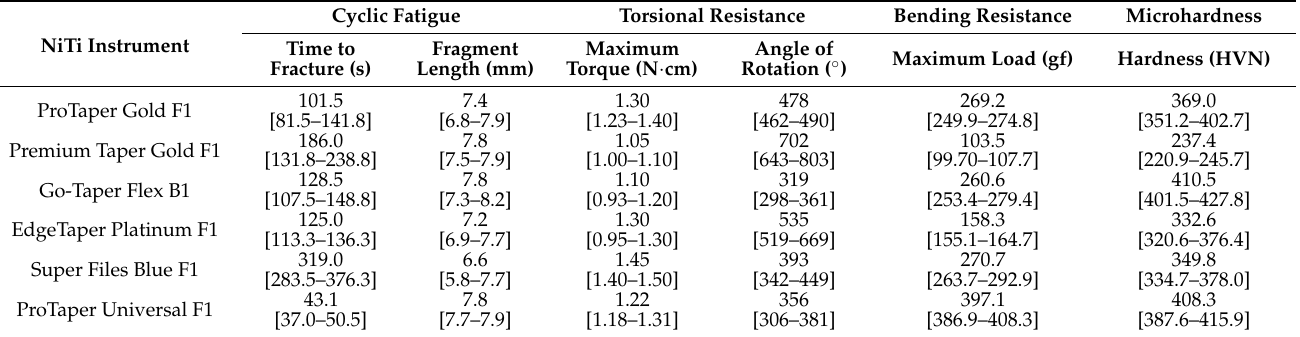
* Figure 5 summarizes the statistical differences among tested